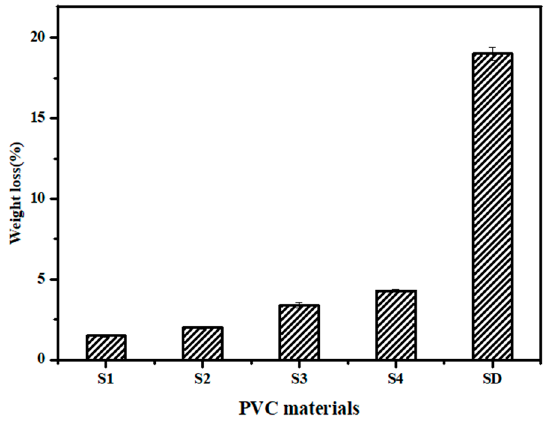
Figure 5. Volatilization resistance of plasticizers.